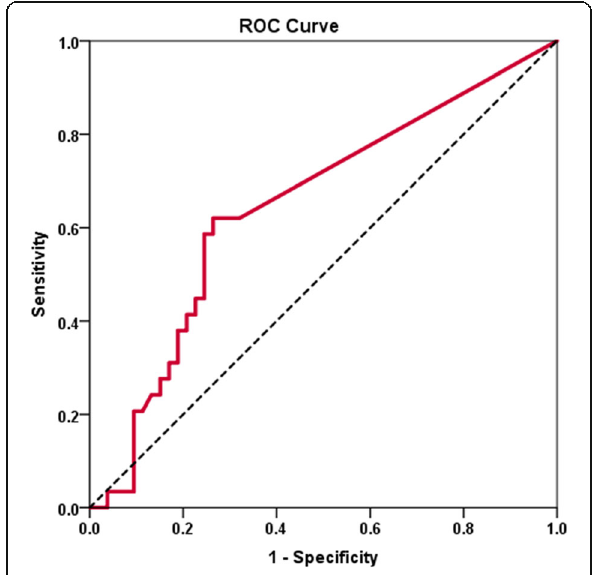
Fig. 2 ROC for serum leptin to discriminate between moderate and severe pneumonia